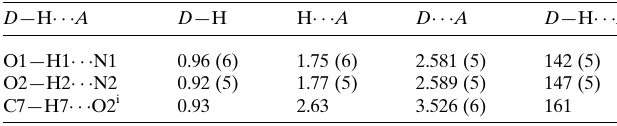
Table 1 Hydrogen-bond geometry (A˚ , (cid:3) ).